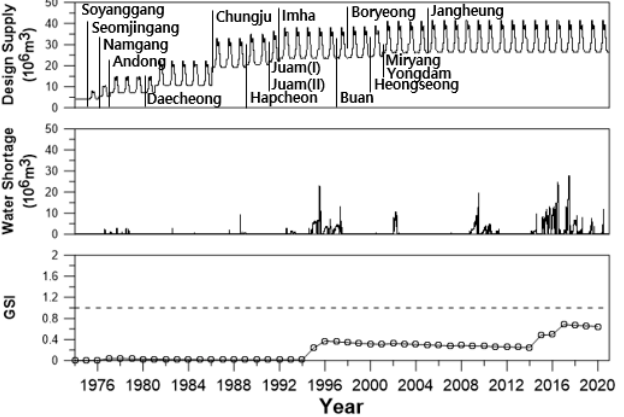
Figure 10. Estimation result of GSI for all the river basins in Korea. Juam (I) and Juam (II) correspond to the Juam Dam and the Juam Controlled Dam, respectively.